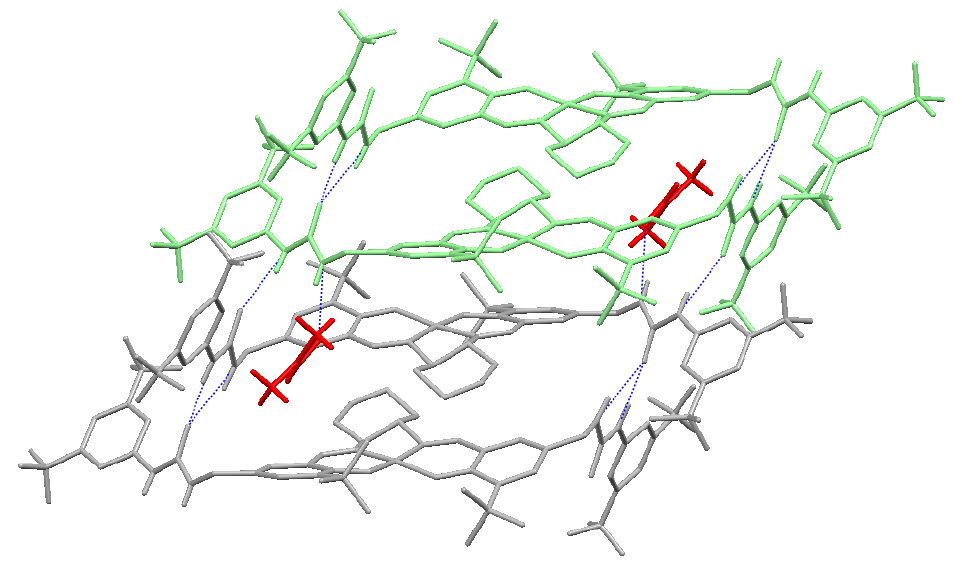
Figure 4. Hydrogen-bond packing structure of bis-urea salen nickel complex.